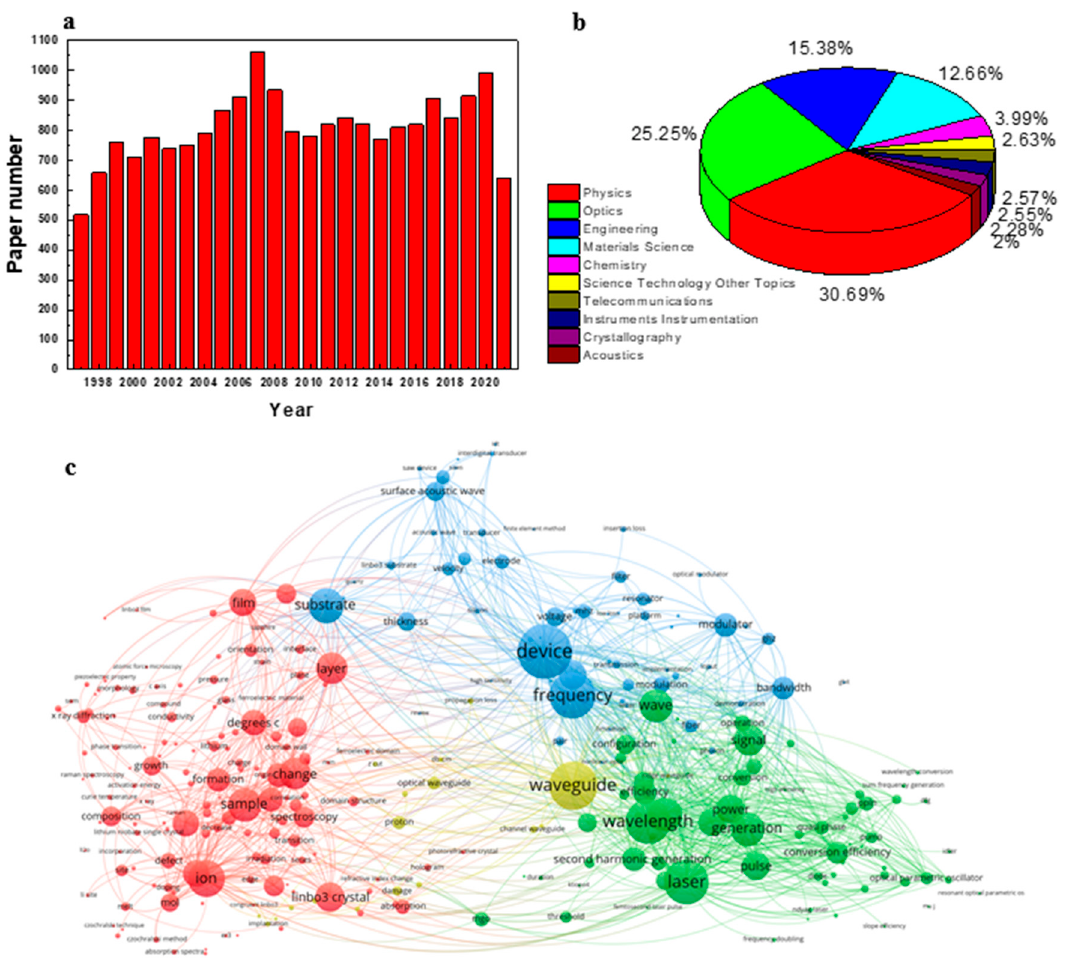
Figure 1. ( a ) Growth of scientific publications referring to LiNbO 3 over 1997–2021. ( b ) Pie chart of research areas about LiNbO 3 . ( c ) Hot research directions of LiNbO 3 crystals. The results of a search performed using “Topic = LiNbO 3 or lithium niobate” on Web of science.